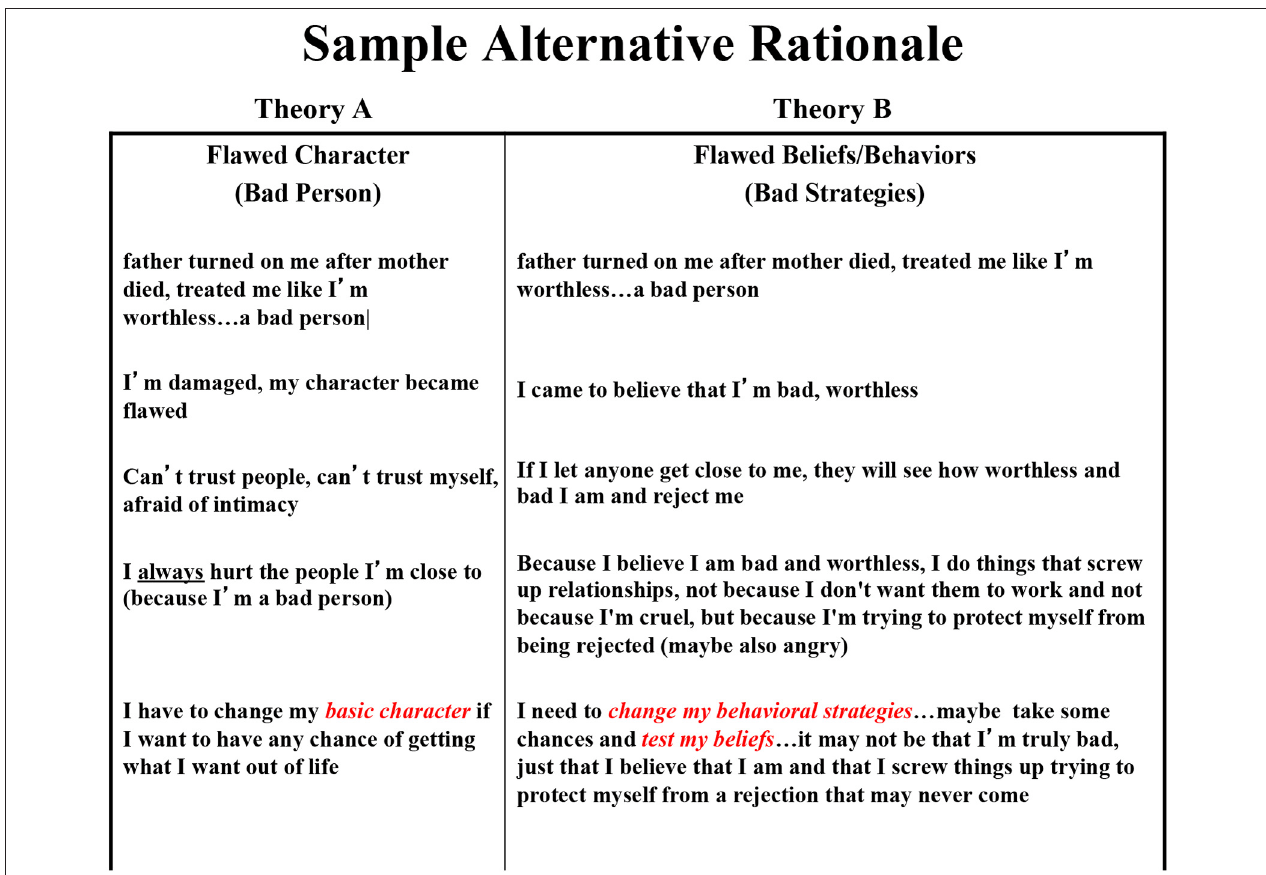
FIGURE 1 | Sample alternative